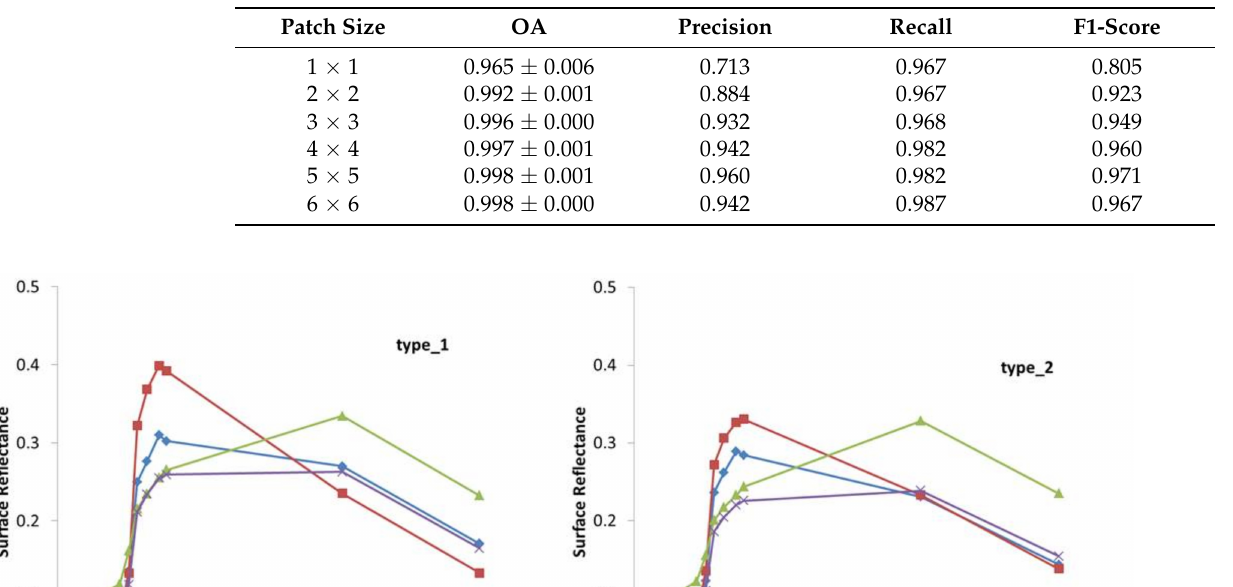
Table 5. OA%, precision, recall and F1-score averaged over all classes considered.